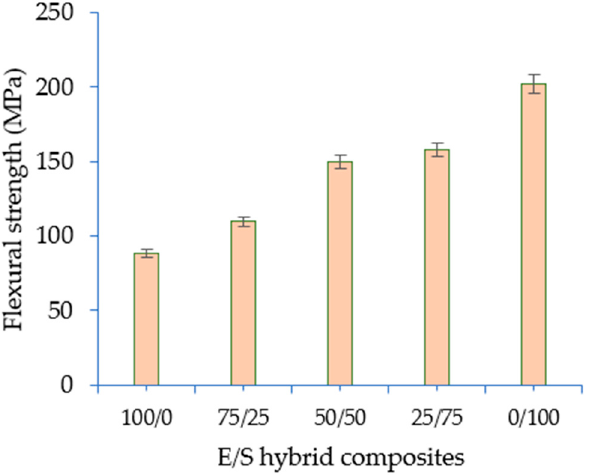
Figure 5. Flexural strength test result.